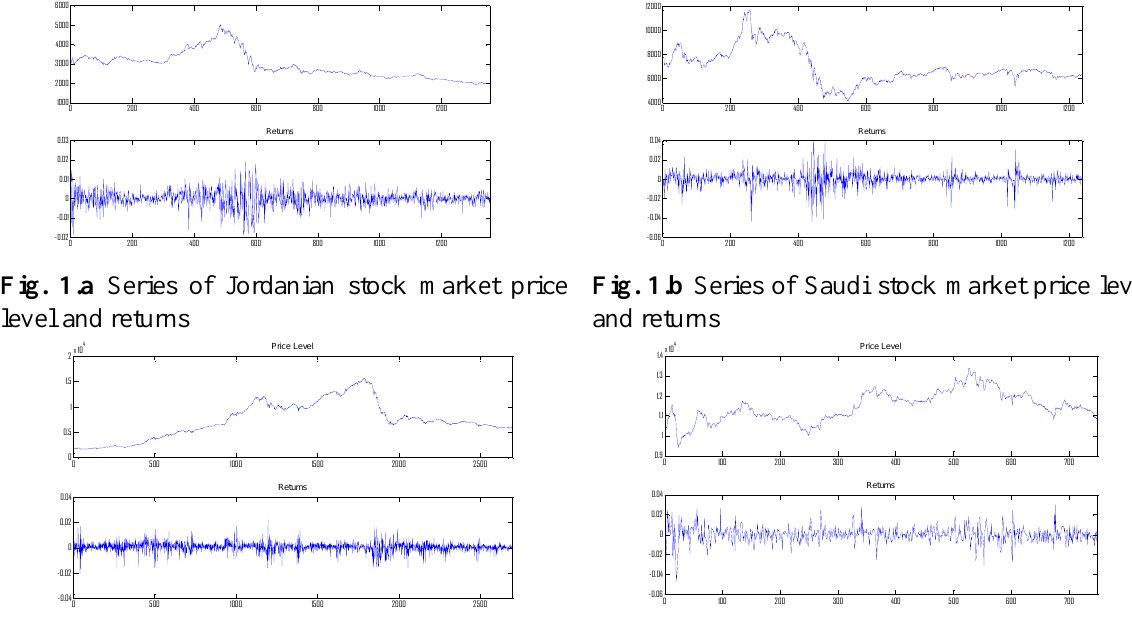
Fig. 1.c Series of Kuwaiti stock market price level and returns